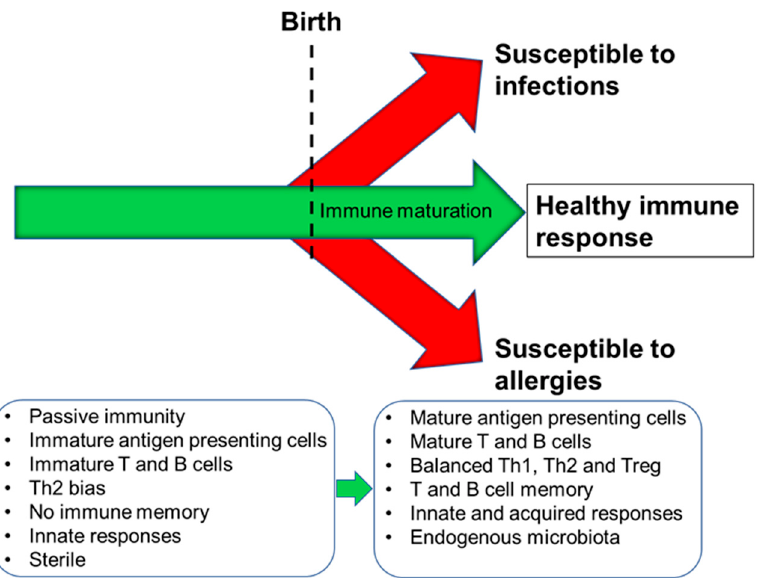
Figure 2. Schematic depiction of immune maturation and the possible outcomes. Th1, T helper 1; Th2, T helper 2; Treg, regulatory T